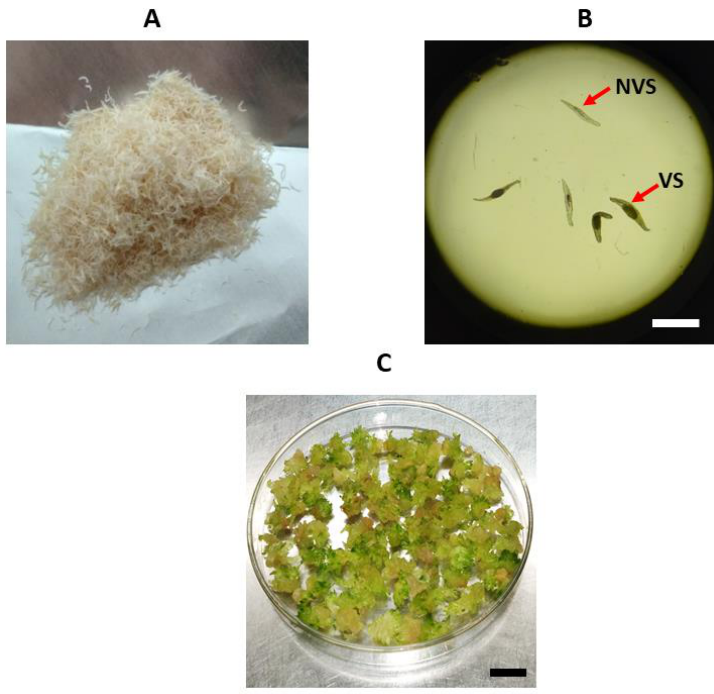
Figure 8. Types of explants used for polyploidy induction: ( A ) macroscopic view of the seeds; ( B ) microscopic view ( × 40) of viable seeds (VS) containing embryos and non-viable seeds (NVS); ( C ) protocorms used in colchicine treatments. Scale bar = 1mm ( B ) and Scale bar = 1 cm ( C ).